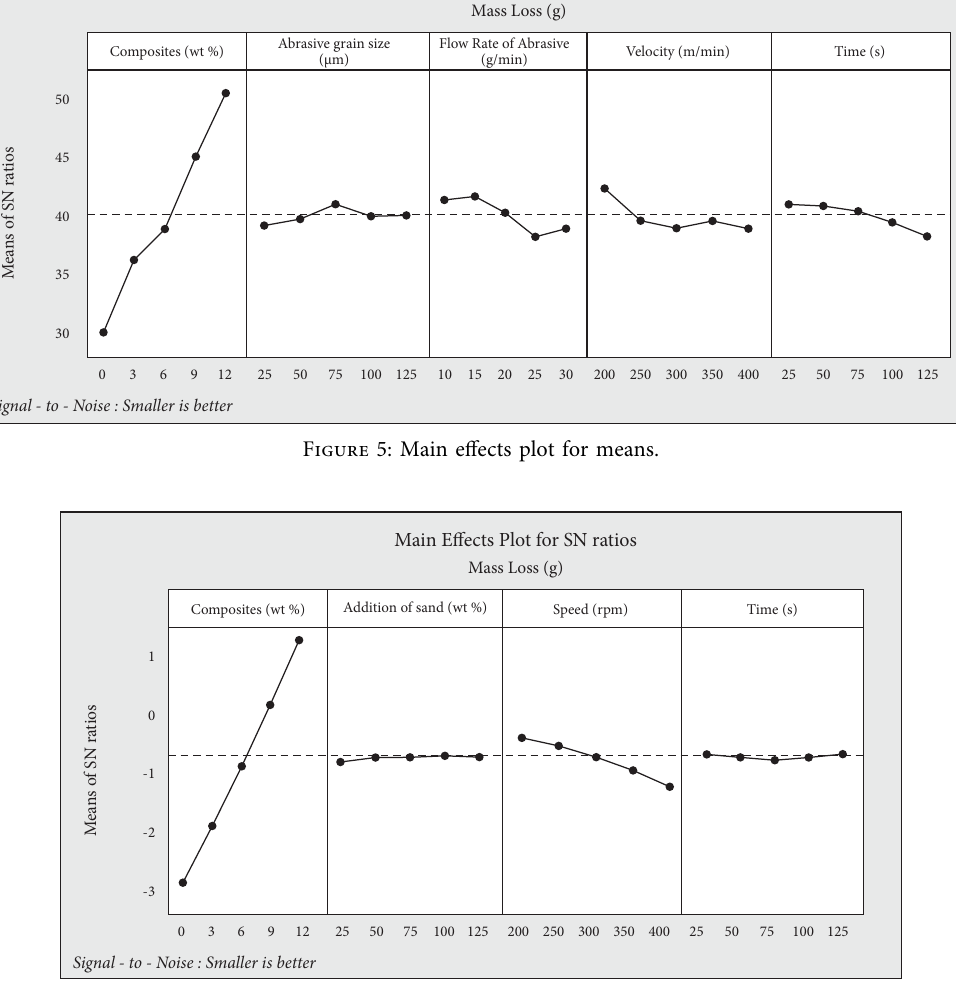
Figure 6: Main efect for the S/N ratio. Table 9: Mean’s response table (erosion wear). Table 10: S/N ratio’s response table (erosion